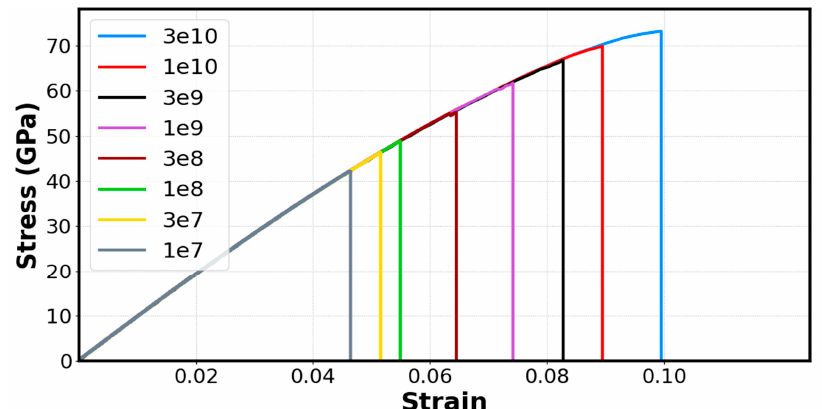
Figure 5. Stress–strain relationships of cracked SLGSs for different strain rates (s − 1 ) . The strain rate ranges from 10 7 s − 1 to 3 × 10 10 s − 1 . The tensile simulations were carried out under the following conditions: The temperature was 300 K. The pressure was 0.0001 GPa (1 atm). The model I loading was applied along the x axis (armchair direction). The system size was 4 × 4 (or 20.7 nm × 20.5 nm with 16,128 lattice sites). All the systems had pre-cracks in the shape of an isosceles right